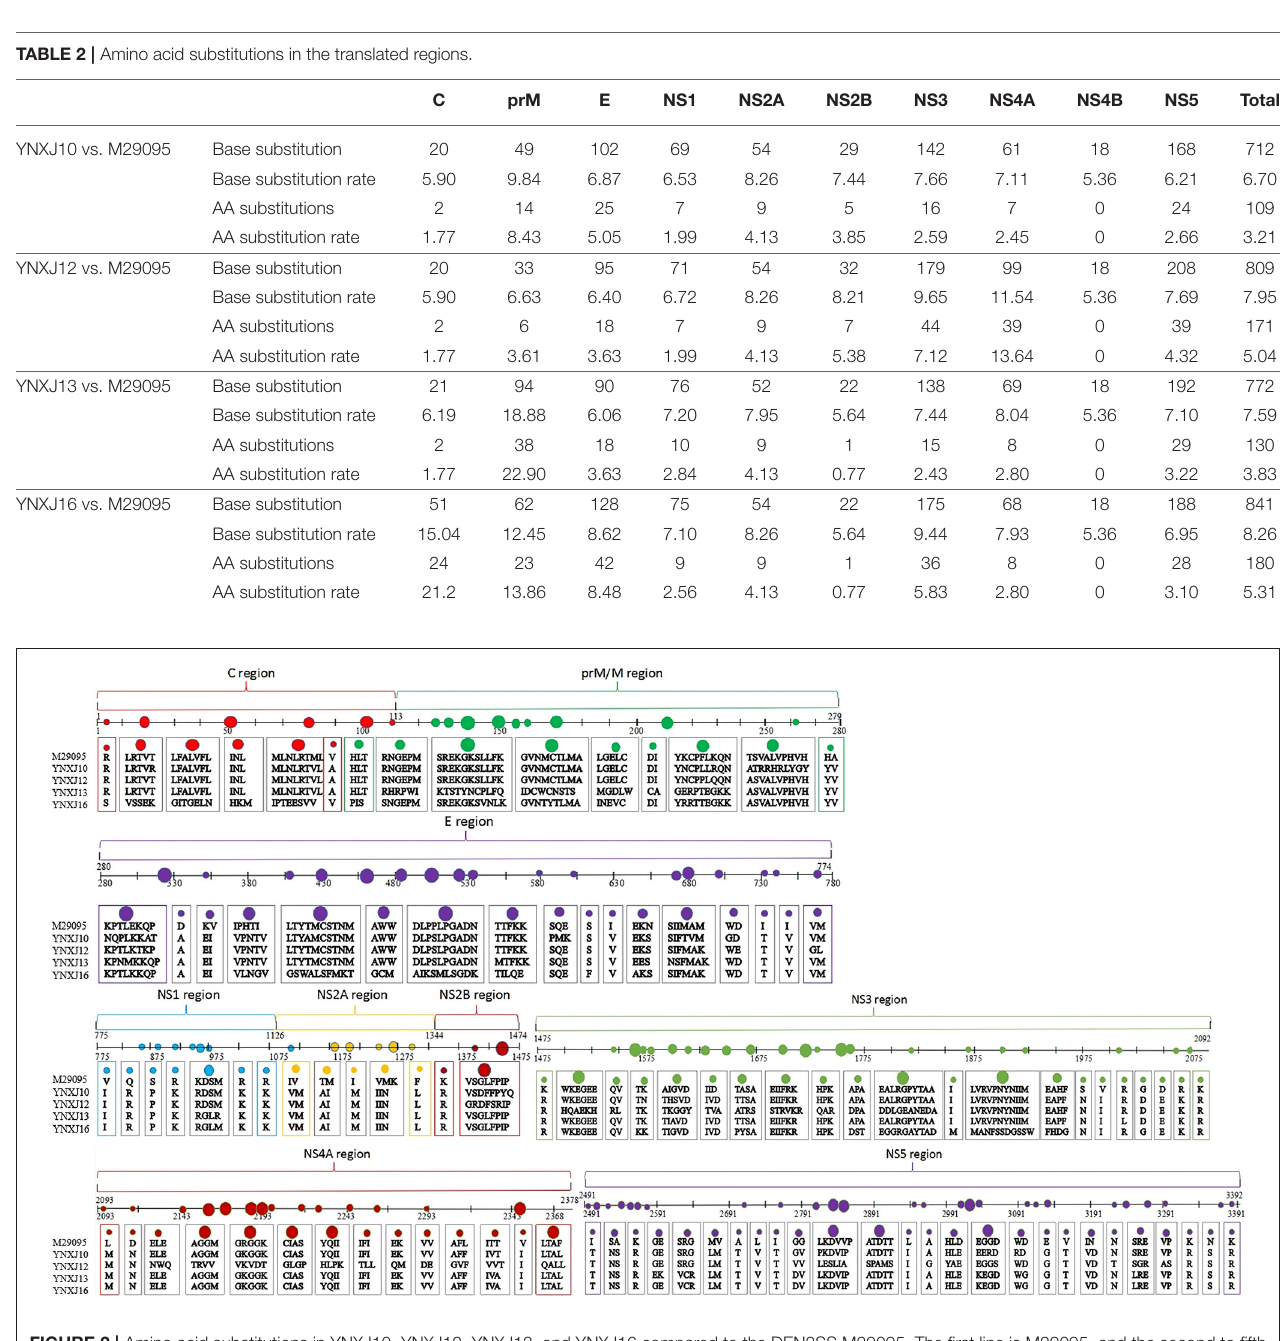
Frontiers in Cellular and Infection Microbiology | www.frontiersin.org